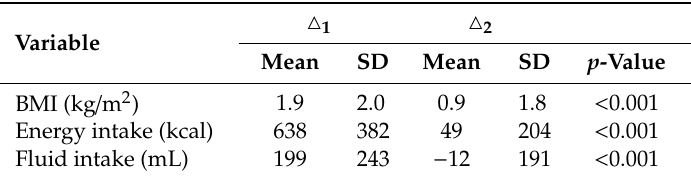
Table 3. Amount of change in each parameter during the period immediately prior to death and during the preceding